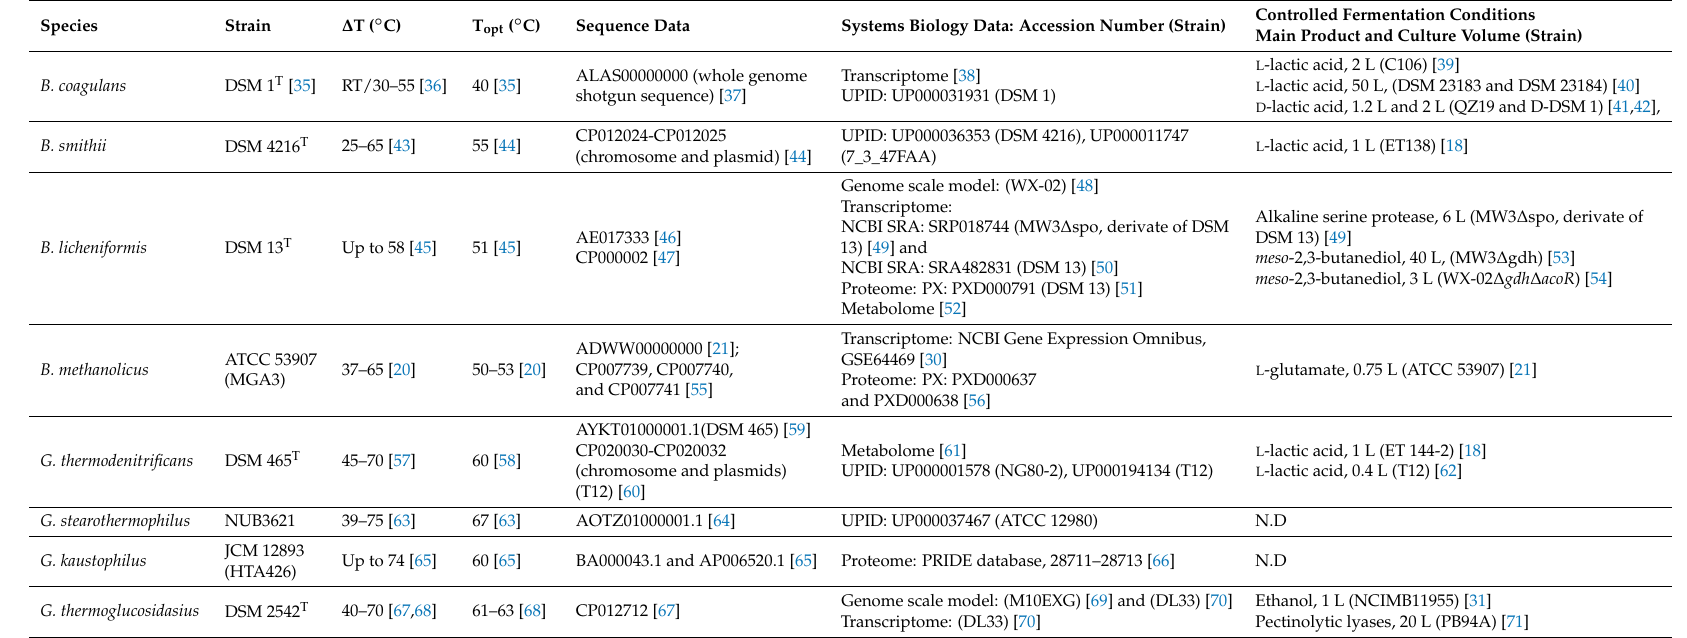
Table 1. Overview of growth temperatures, genome sequences, accession numbers, and selected high cell density cultivations for thermophilic Bacillaceae.